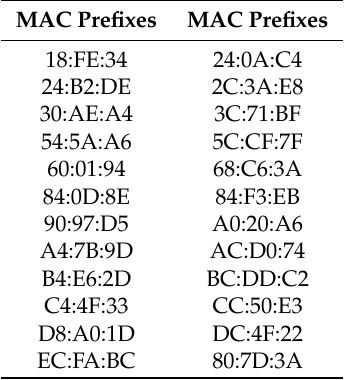
Table 5. Discovered MAC address prefixes assigned to Espressif